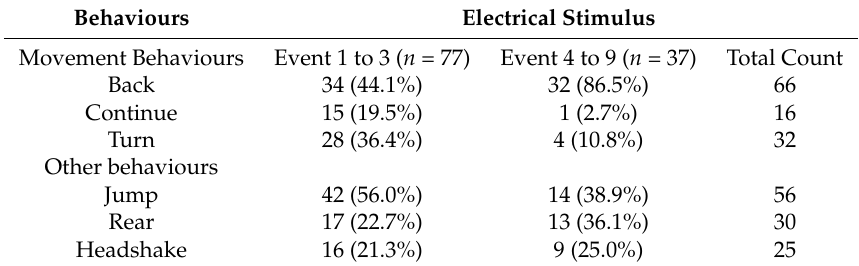
Table 3. Count of the behaviours displayed by sheep following a low-level electrical stimulus ( n = 114) during associative training, n is the number of entries into the exclusion zone. Proportions are displayed in brackets. Animals were able to display more than one reaction in one interaction with the virtual fence, such as a head shake and run